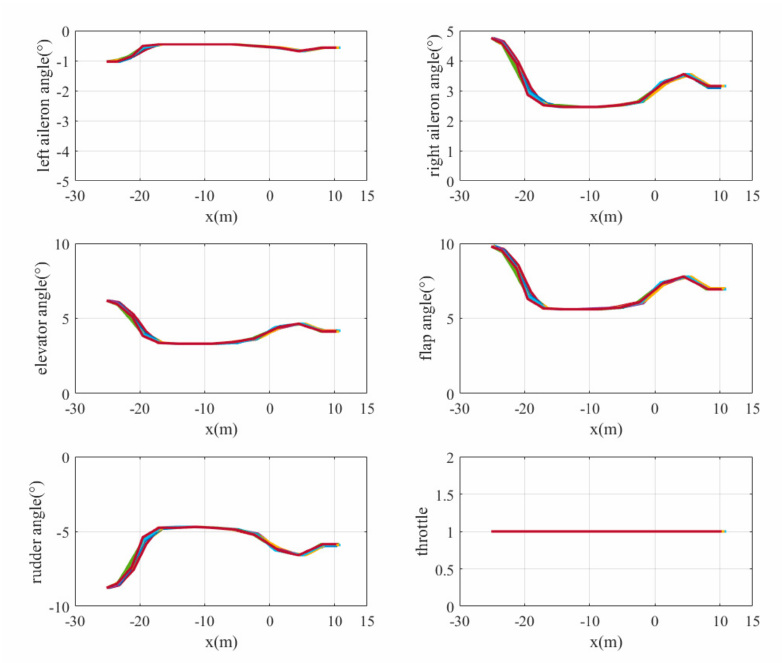
Figure 16. The control commands for the actuators under case